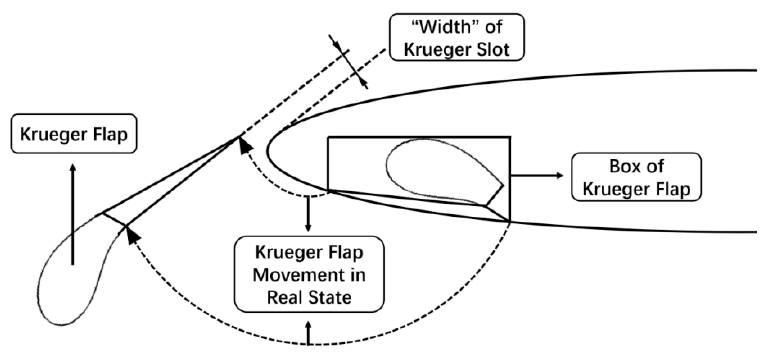
Figure 2. Krueger flap movement in real state.